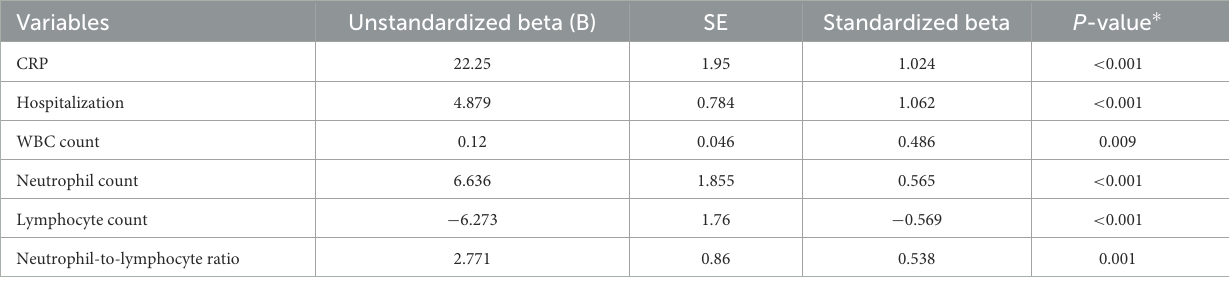
TABLE 4 Association of inflammatory and immune system biomarkers with dietary inflammatory index (DII) in patients with COVID-19 based on multiple linear regression. Variables